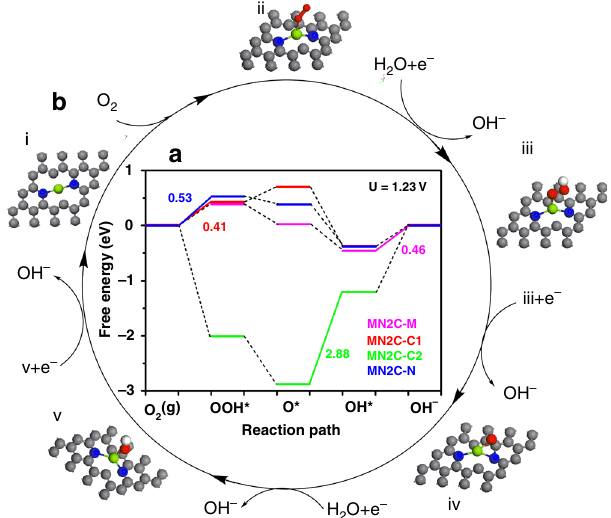
Fig. 5 The free energy diagram of MN2C and its possible reaction pathway. a The free energy diagram of MN2C at different optimized adsorbed reaction sites at 1.23 V and the full oblique lines and corresponding value shows the RDS and energy barriers of catalysts. b Favorable reaction pathway of MN2C. And the active sites are Mg and C1 atoms. Green, blue, red, white and gray balls represent metal, N, O, H, and C atoms, respectively. Specially, the O* is adsorbed at both Mg and C1 adjacent to N atoms in